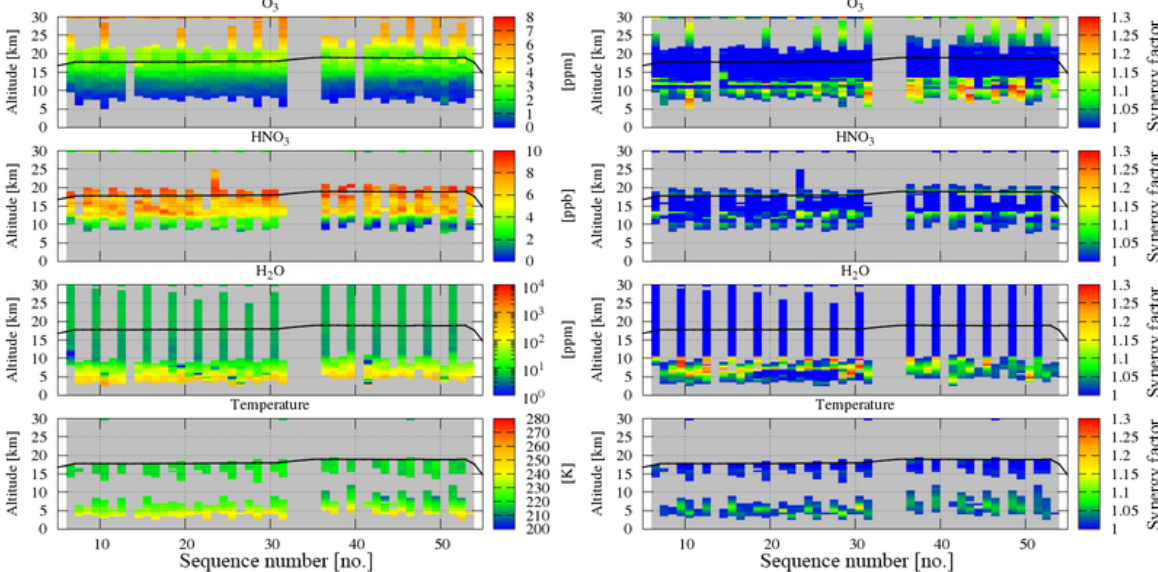
Figure 11. (L1 + L2) method products and SF for the atmospheric targets as resulting from initial retrievals and (L1 + L2) method of MARSCHALS and MIPAS-STR limb sounding